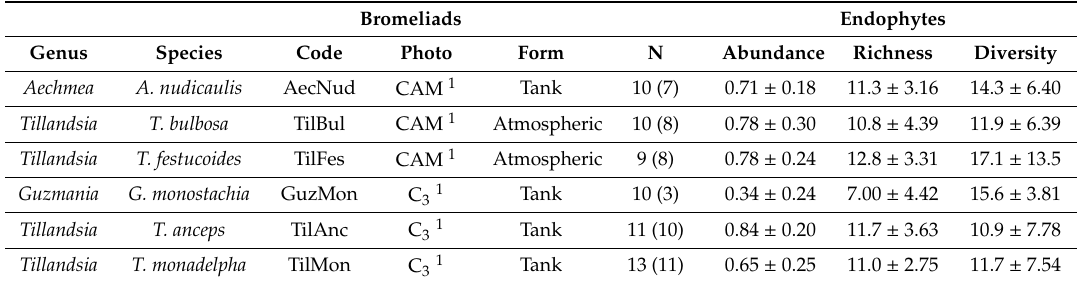
Table 1. Epiphytic bromeliads surveyed from the forest canopy at La Selva Biological Station, Costa Rica. Code: species code; Photo: photosynthetic pathway; Form: morphological life form; N: number of bromeliads sampled and used for abundance and relative abundance estimates (number of bromeliads that produced ≥ 9 OTU and were used in multivariate analyses); Abundance: endophyte isolation frequency (mean ± SD); Richness: number of unique fungal operational taxonomic units (OTUs; mean ± SD); and Diversity: fungal diversity calculated as Fisher’s Alpha (mean ± SD). Bromeliads Endophytes Genus Species Code Photo Form N Abundance Richness Diversity Aechmea A. nudicaulis AecNud CAM 1 Tank 10 (7) 0.71 ±